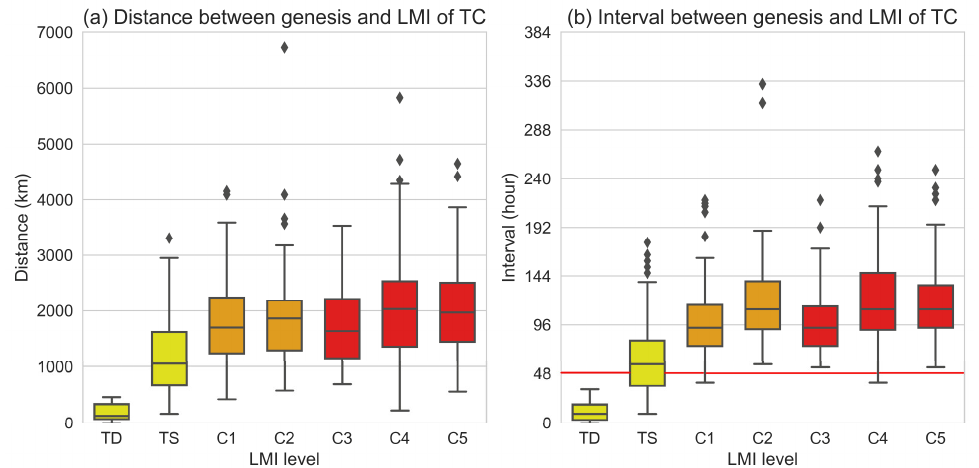
Figure 2. Box-and-whisker plots of ( a ) distance (km) and ( b ) interval (hour) between locations of TC genesis and LMI over the WNP grouped by LMI level (yellow for TD/TS, orange for minor TC, and red for major TC). Boxplot displays median (horizontal black line near box center), interquartile range (box perimeter; [ q 1 , q 3 ]), whiskers (black lines; [ q 1 − 1.5 ( q 3 − q 1 ), q 3 + 1.5 ( q 3 − q 1 )]), and outliers (rhombic points). The red horizontal line in ( b ) is a reference for the interval of 48